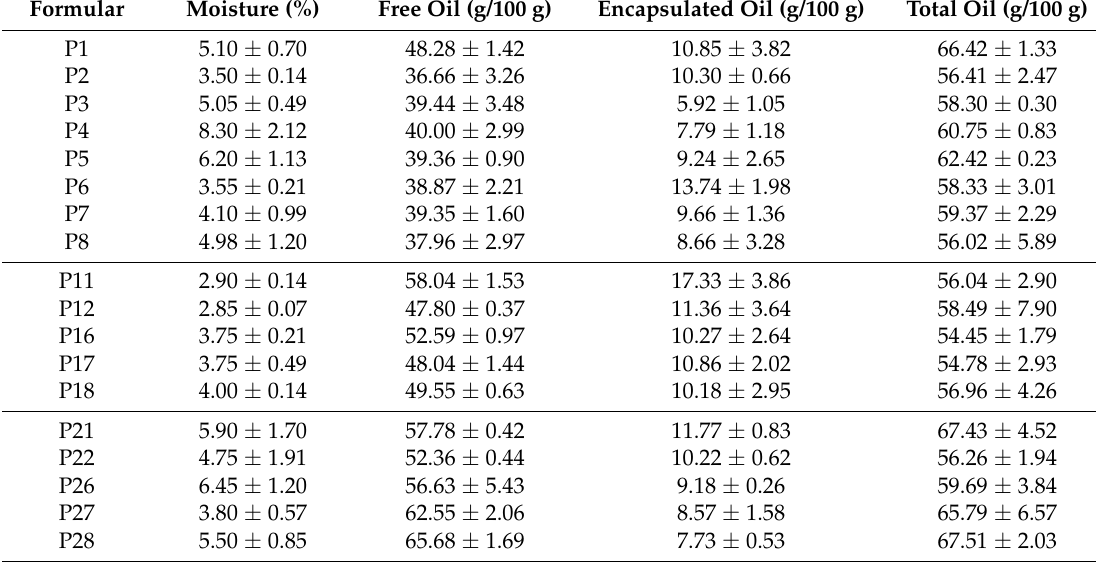
Table 2. The comparison of spray-dried olive oil powder by determining the moisture amount and oil amount (free oil, encapsulated oil and total oil) (n = 3).